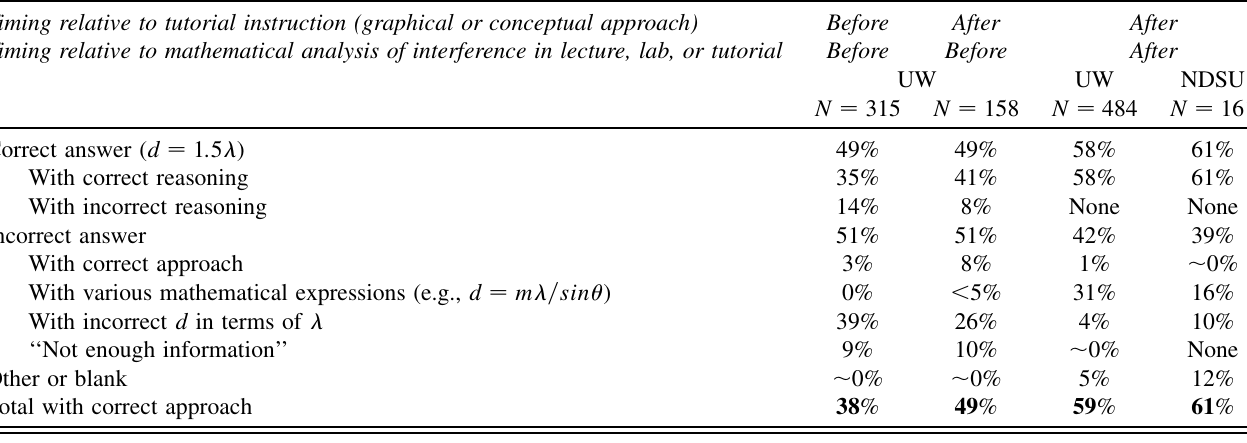
TABLE V. Summary of results from the slit separation task at different stages of instruction at UW and NDSU. (Some of these data also appear in other tables; they are repeated here to facilitate comparisons.) Timing relative to tutorial instruction (graphical or conceptual approach) Timing relative to mathematical analysis of interference in lecture, lab, or tutorial